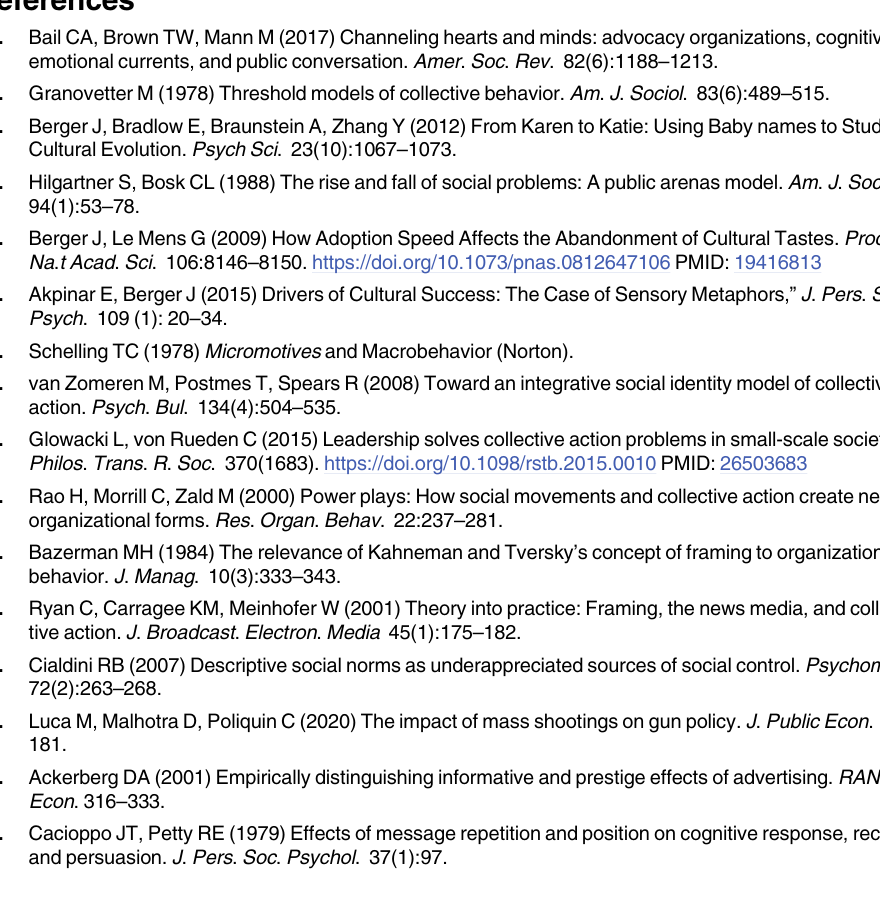
S1 Table. Descriptive statistics. S2 Table. Model validation. S3 Table. Robustness to aggregation